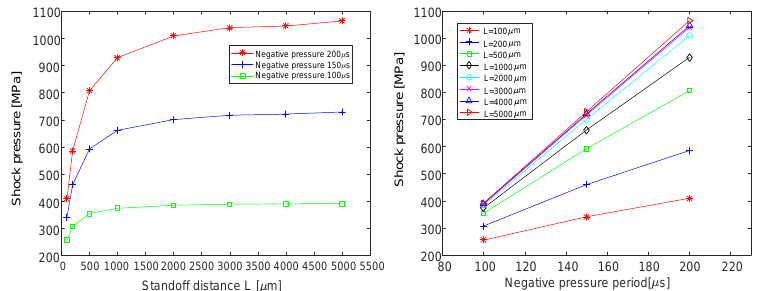
Figure 10. Relation between negative pressure and initial bubble radius on maximum shock pressure at constant standoff distance 1000 µ m.